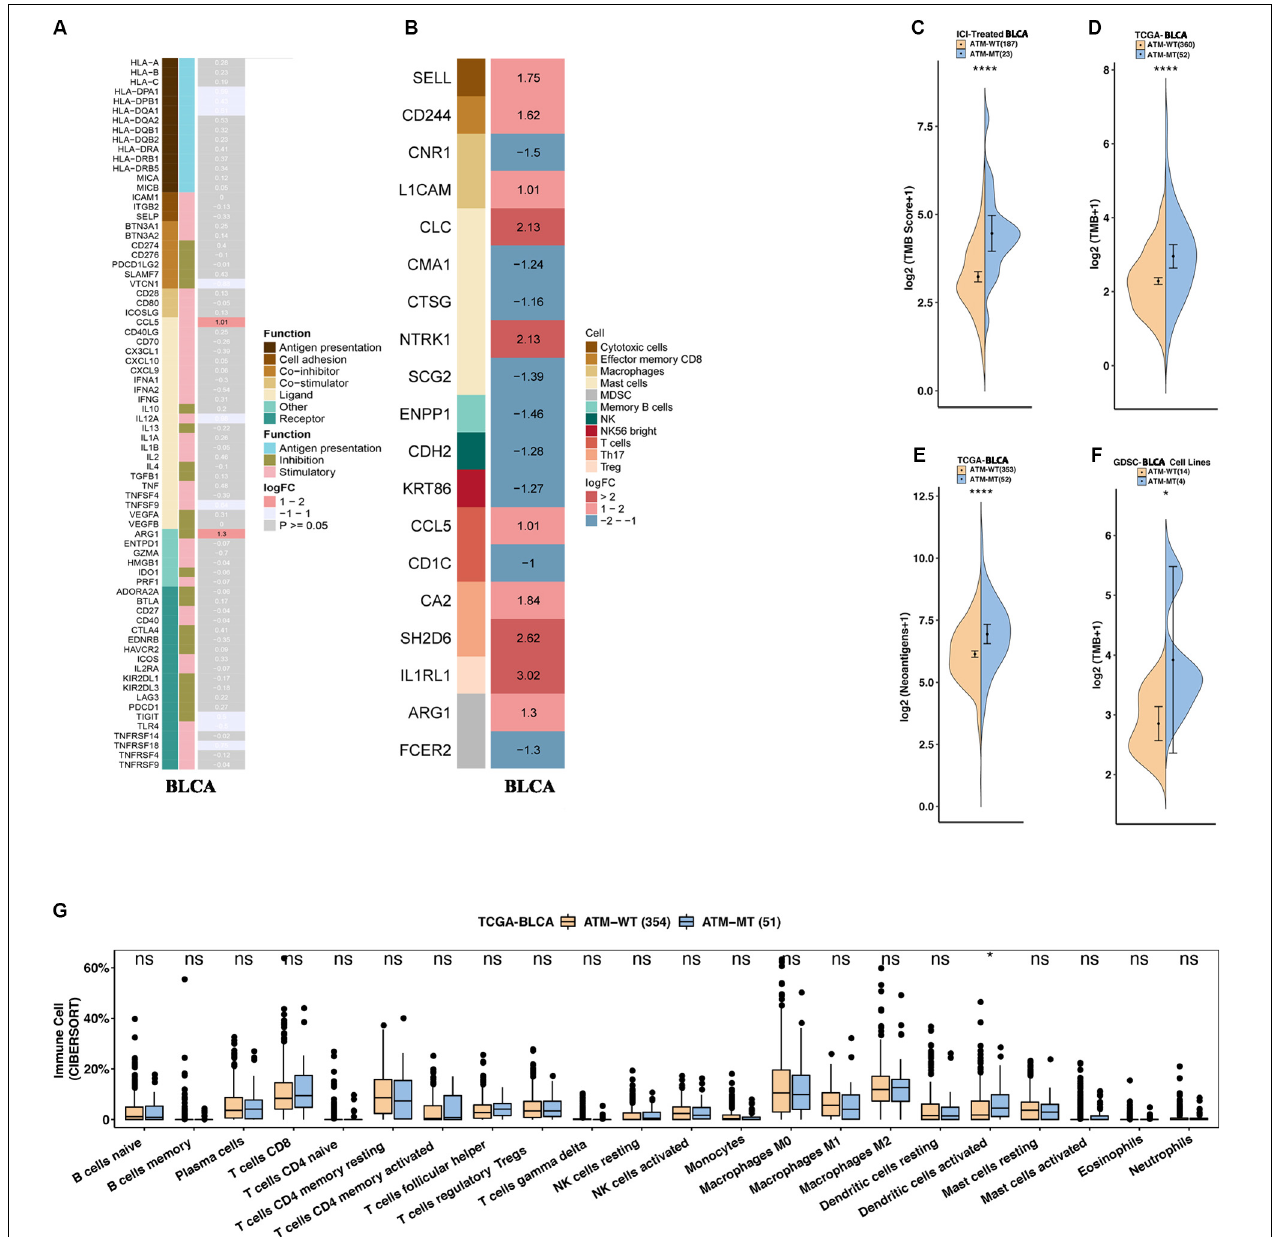
FIGURE 3 | ATM mutation was associated with enhanced tumor immunogenicity and activated antitumor immunity. (A) Heatmap showing average changes in the expression levels of immune-related gene between the ATM-MT and ATM-WT patients in the TCGA-BLCA cohort. The genes corresponding to the same lymphocyte or function are identified by the same color on the left side of the squares, and each square with an exact number represents the logFC of a gene, filled with different back colors, i.e., from red to gray. The logFC values marked in black font indicate that the absolute value of logFC is ≥ 1 with statistical significance ( P < 0.05), while the logFC values in white font are non-significant ( P > 0.05). Using Mann–Whitney U test tested the differences in tumor-infiltrating lymphocytes and immune-related gene expression between ATM-MT and ATM-WT samples. (B) Heatmap showing average changes in the expression levels of immune-cell-related gene between the ATM-MT and ATM-WT patients in the TCGA-BLCA cohort. The genes corresponding to the different cell types are identified by the different colors on the left side of the squares, and each square with an exact number represents the logFC of a gene, filled with different back colors, i.e., from red to blue. The logFC values marked in black font indicate that the absolute value of logFC is ≥ 1 with statistical significance ( P < 0.05). Using Mann–Whitney U test tested the differences in immune-cell-related gene expression between ATM-MT and ATM-WT samples. (C) Comparison of the tumor mutational burden between the ATM-MT and ATM-WT tumors in the immunotherapy cohort. (D) Comparison of the tumor mutational burden between the ATM-MT and ATM-WT tumors in the TCGA-BLCA cohort. (E) Comparison of the neoantigen load between the ATM-MT and ATM-WT tumors in the TCGA-BLCA cohort. (F) Comparison of the tumor mutational burden between the ATM-MT and ATM-WT tumors in the GDSC-Bladder cancer cell line dataset. (G) CIBERSORT analyses quantifying the proportion of 22 immune cells in the ATM-MT and ATM-WT tumors in the TCGA-BLCA cohort. (C–G) , * p < 0.05; **** p < 0.0001.